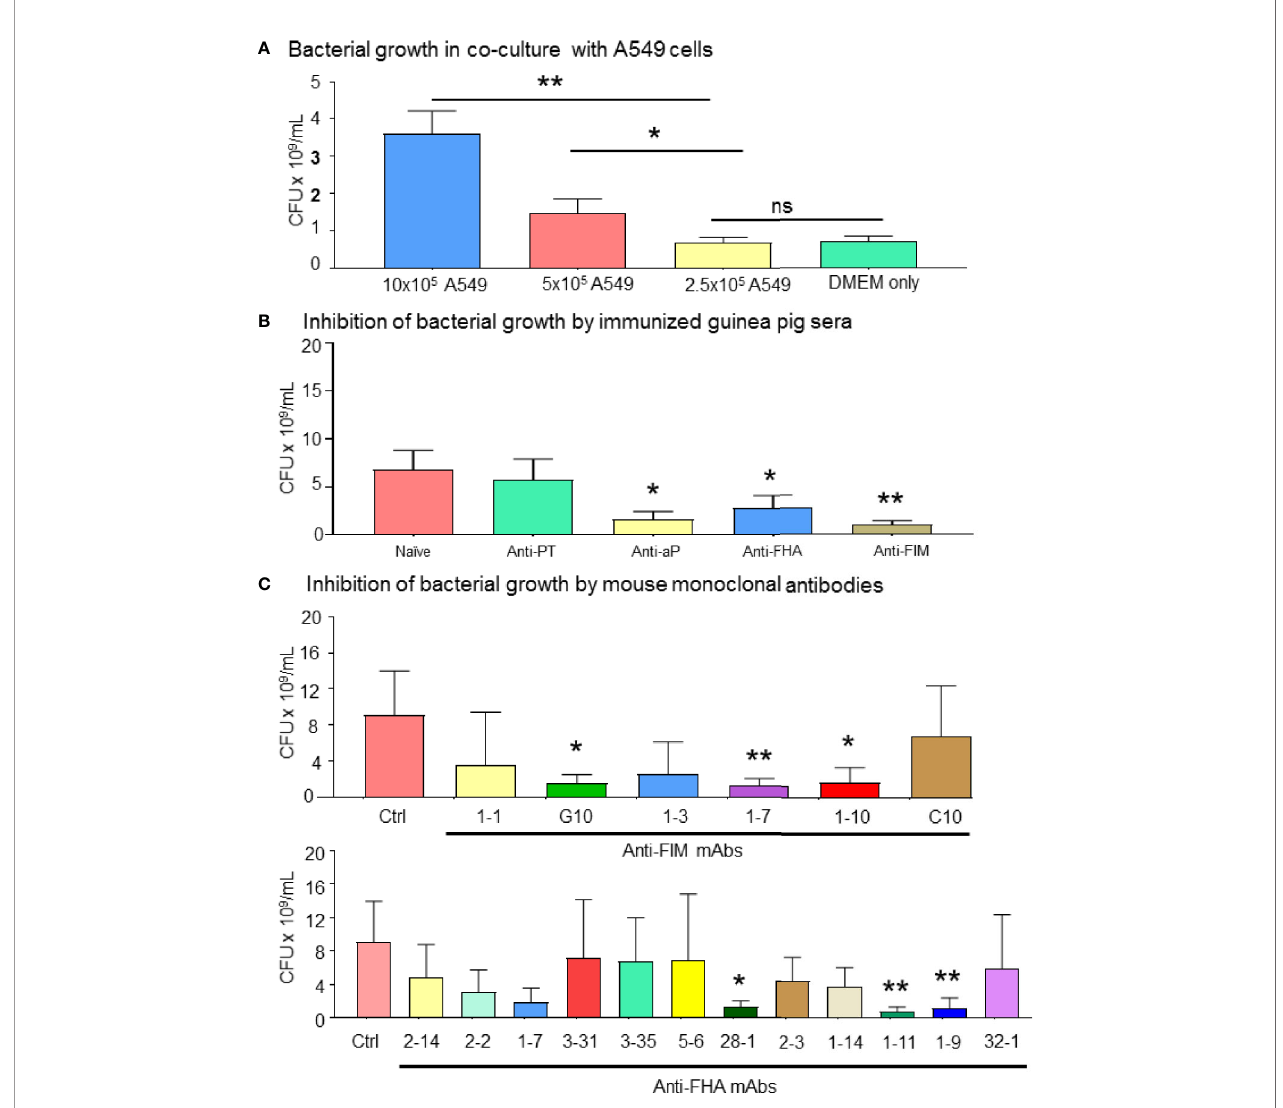
FIGURE 1 | Bordetella pertussis interactions with A549 epithelial cells are essential for bacterial growth which is inhibited by speci fi c mAbs. (A) B. pertussis growth signi fi cantly increased in a dose dependent manner in presence of 1 and 0.5 million of A549 cells. After 72 h co-culture of B. pertussis with A549 cells, extracellular bacterial concentration in the medium was determined. (B, C) Enumeration of live bacteria on Bordet-Gengou blood agar showed signi fi cant inhibition of B. pertussis growth by anti-sera (B) compared to naïve control sera. Mouse mAb targeting FIM (G10, 1-7, and 1-10) and FHA (28-1, 1-11, and 1-9) signi fi cantly inhibited bacterial growth compared to anti-RSV control mAb (C) . Unpaired Student ’ s t -test. Mean±SEM. * p <0.05, and ** p <0.01, n ≥ 4 experiments. ns, non signi fi